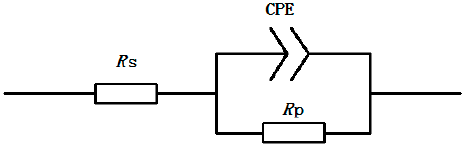
Figure 11. The equivalent circuit of R s( QR p), where R s is solution resistance; R p is polarization resistance; Q is capacitance of CPE (Constant Phase-angle Element).